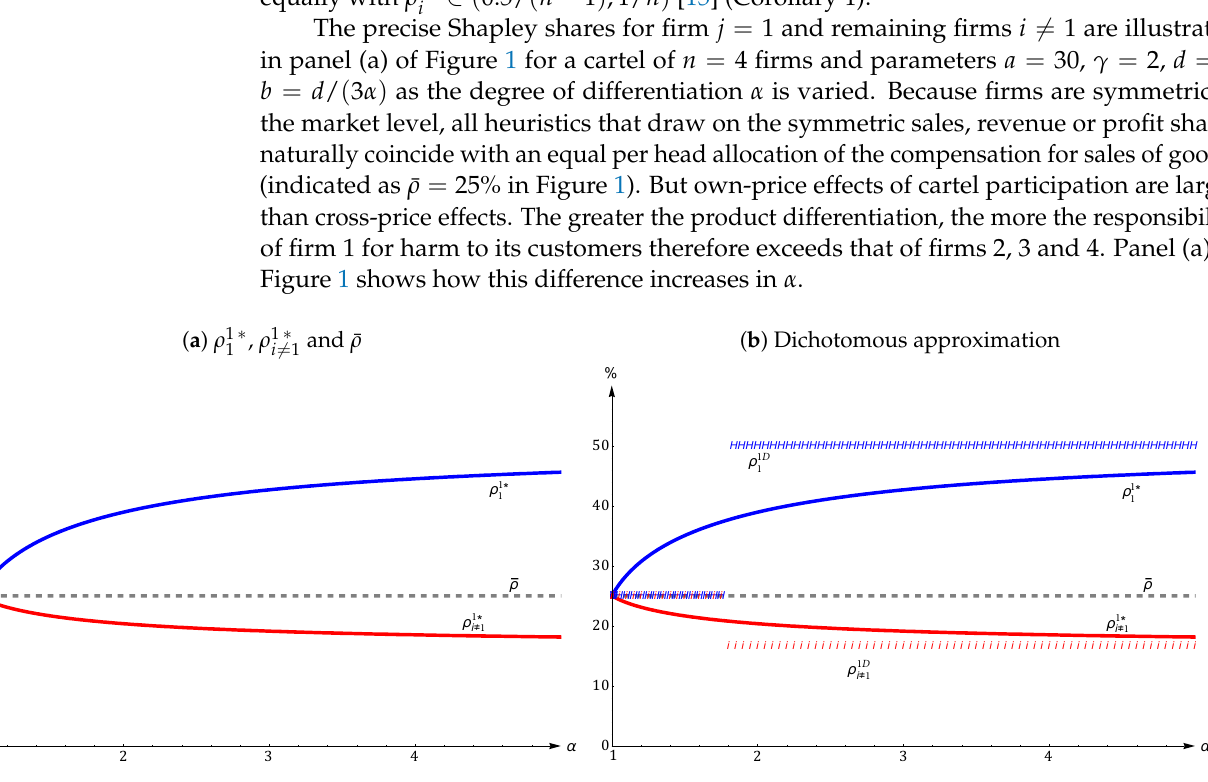
Figure 1. ( a ) Shapley shares ρ 1 ∗ and equal ad hoc shares ¯ ρ vs. ( b ) shares ρ 1 D implied by dichotomous approximation when proportioning compensation for purchases of good 1 in a linear Bertrand model with symmetric